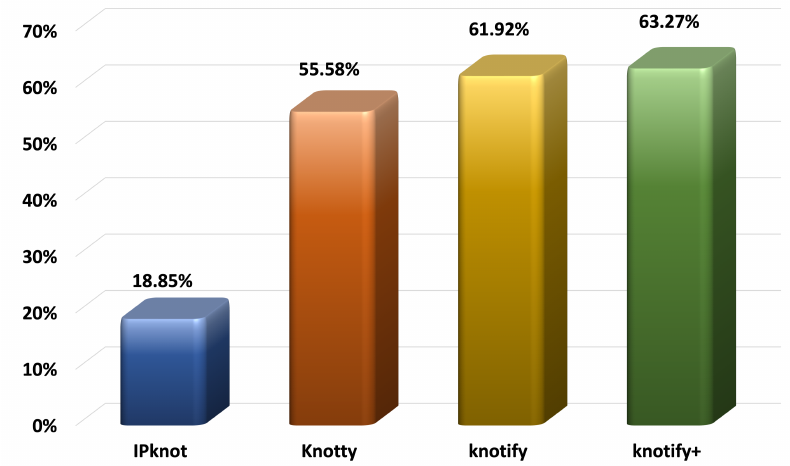
Figure 5. Percentage of at least one core stem prediction for each